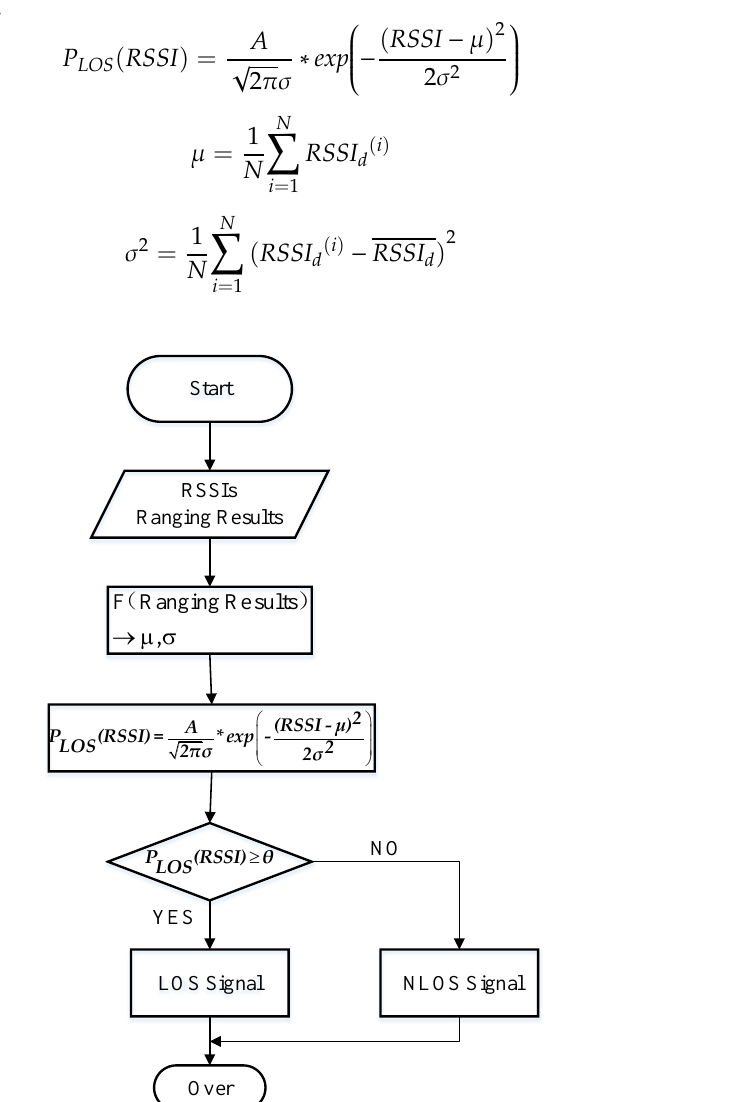
/ NLOS identification